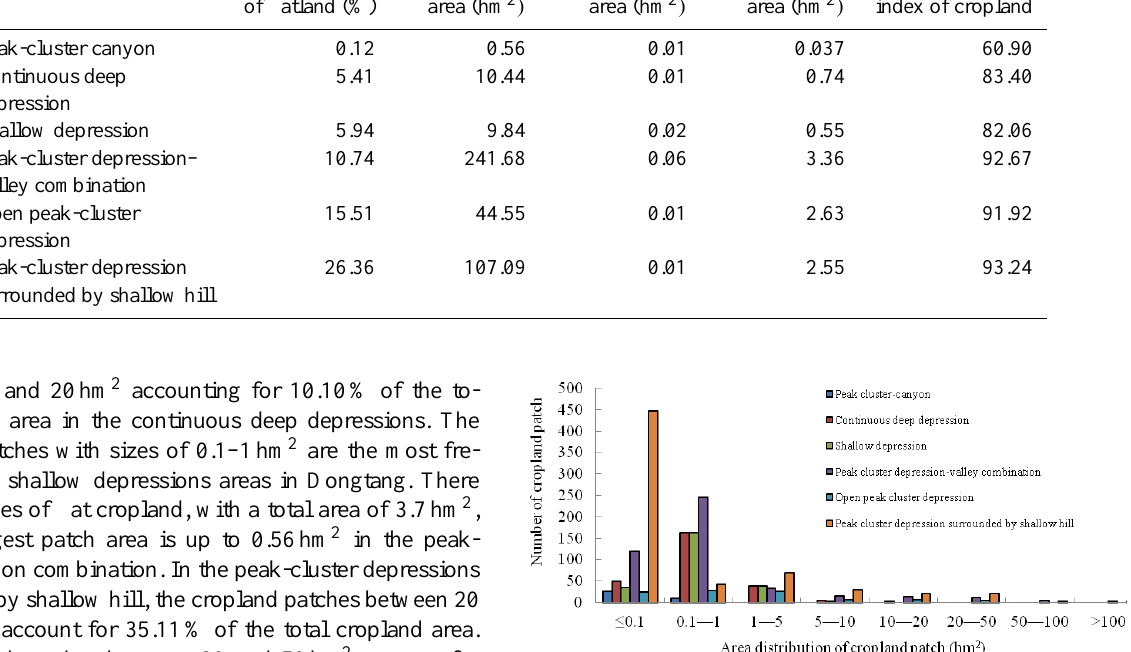
Table 1. The characteristics of cropland patch in the study areas. Land form Percentage Largest patch Smallest patch Average patch Aggregation of flatland (%) Peak-cluster canyon